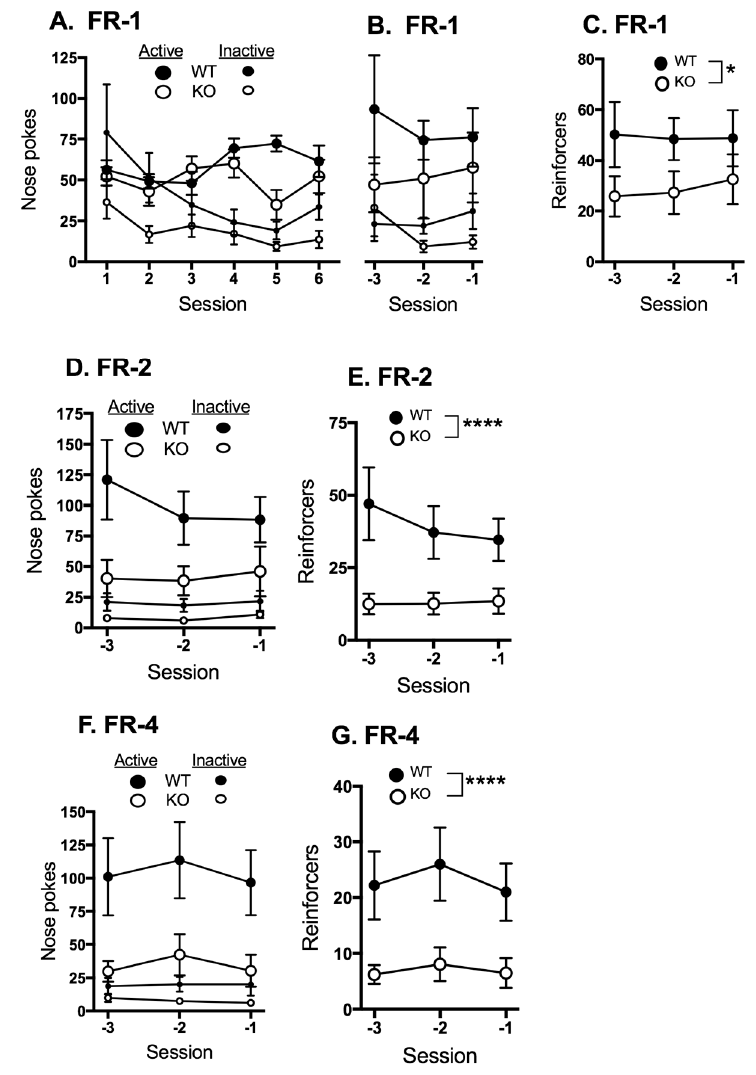
Figure 1. Comparison of wild type (WT) and CB1R knock out (CB1KO) active and inactive nose-poke responses and reinforcers earned during fixed ratio (FR) schedules. Mice (9 WT and 12 CB1KO) were placed into operant chambers with two nose-poke ports for 2 h daily for 6 consecutive days per week. Responses in one of the nose-poke ports triggered a combination of visual and auditory responses, the other did not. Mice progressed through three FR schedules in sequence. Responses in the active port are indicated with large circles, inactive with small circles. Filled circles represent data from WT mice, open circles from CB1KO mice. Mean values are shown, vertical lines represent standard error of the mean (SEM). Negative numbers in panels B–G denote the final three sessions prior to the session in which criteria were met for promotion of each animal to the next schedule. ( A ) Mean nose-poke responses in the active and inactive ports during the first six sessions of FR-1; ( B ) Mean nose-poke responses in the active and inactive ports during the final three sessions of FR-1; ( C ) Mean reinforcers earned during the final three sessions of FR-1; ( D ) Mean nose-poke responses in the active and inactive ports during the last three sessions of FR-2; ( E ) Mean reinforcers earned during the last three sessions of FR-2; ( F ) Mean nose-poke responses in the active and inactive ports during the last three sessions of FR-4; ( G ) Mean reinforcers earned during the last three sessions of FR-4. * p < 0.05, **** p < 0.0001.